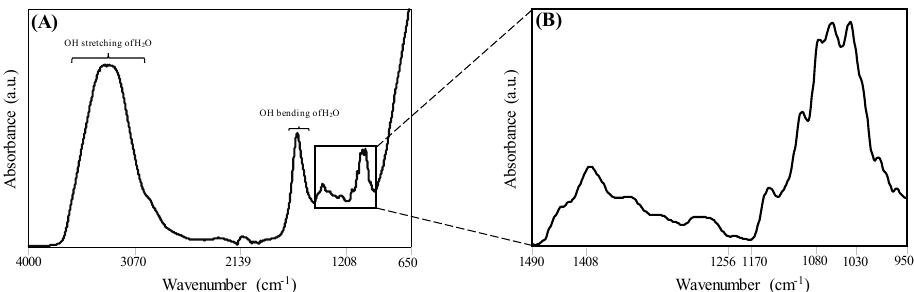
Figure 1. ( A ) A representative raw infrared absorption spectrum of tomato paste samples in the region of 4000–650 cm − 1 and ( B ) the tomato paste spectrum in the 1490–950 cm − 1 region utilized in chemometric analysis.